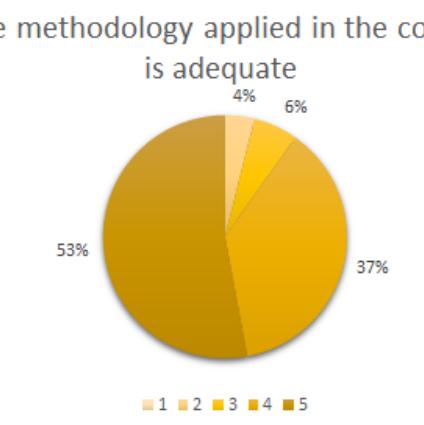
Figure 5. Students’ perceptions of assertion 2.